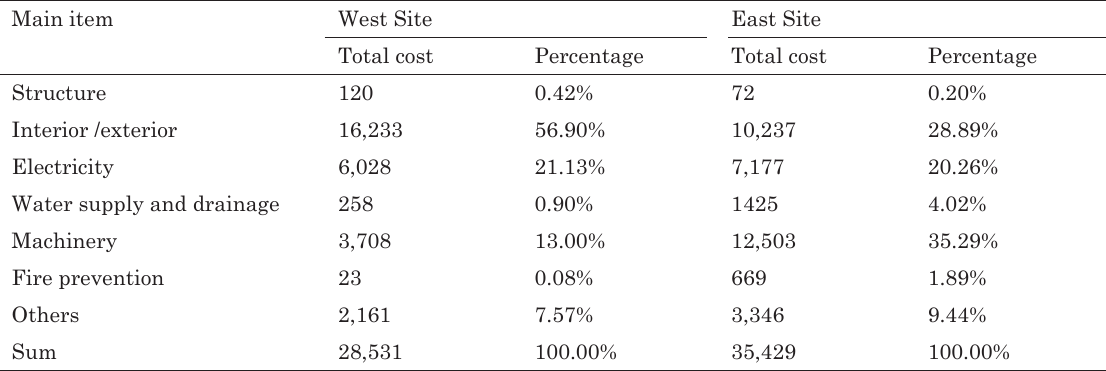
table 3. Cost distribution of nTUH